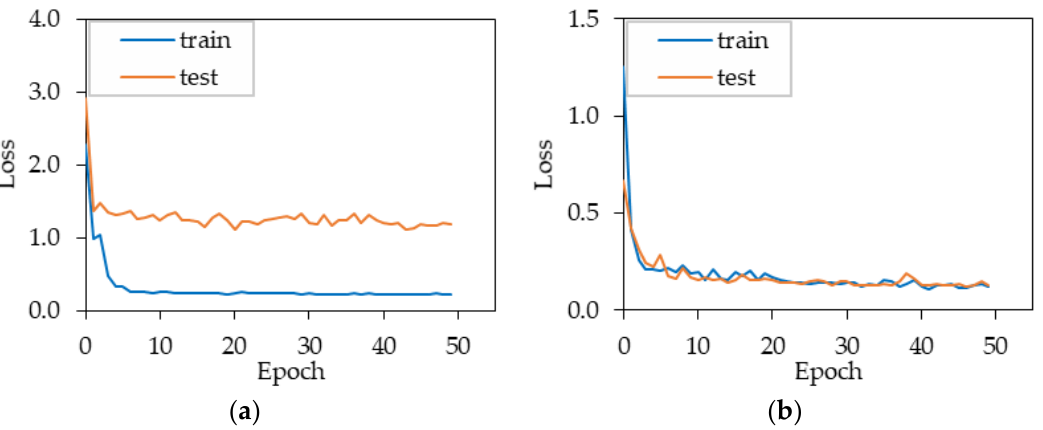
Figure 11. Error-epoch charts of training and testing sets of the proposed estimation model. ( a ) Direction along the river. ( b ) Vertical direction. Table 2. Evaluation results of the proposed model.